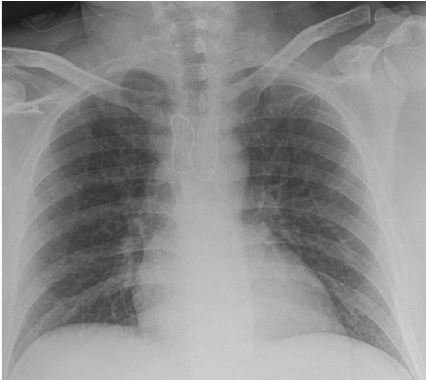
Figure 3: Metallic spring deployed in the upper thoracic esophagus 21 cm from the incisors.